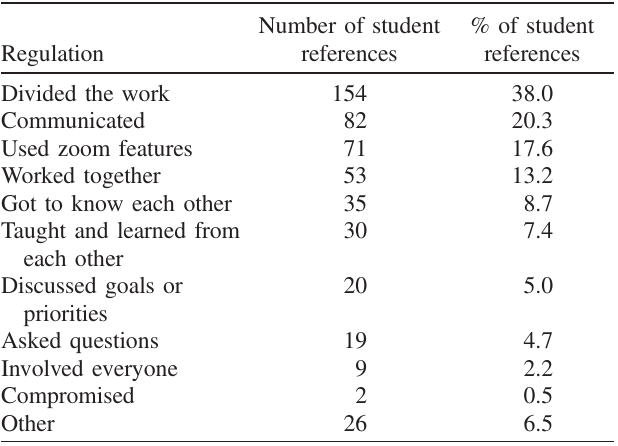
TABLE V. Regulation types referenced in the memos to future researchers. The percent of students is calculated from the total number of memos, n ¼ 403